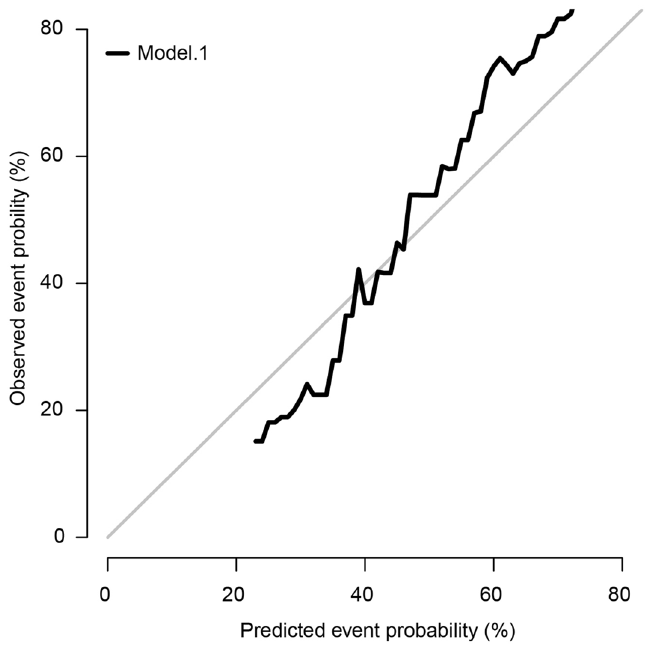
Figure 4. The calibration curve to show the consistency between the nomogram-predicted probabilities and actual